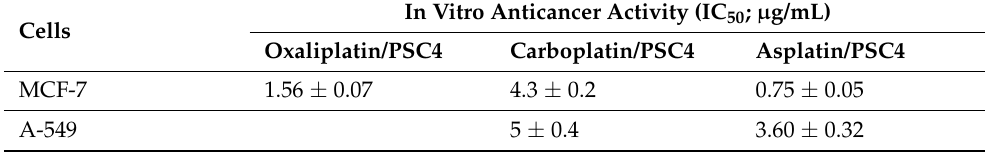
Table 3. Comparison between the in vitro anticancer activities of oxaliplatin/PSC4, carboplatin/PSC4, and asplatin/PSC4 complexes against MCF-7 and A-549 cancer cell lines.